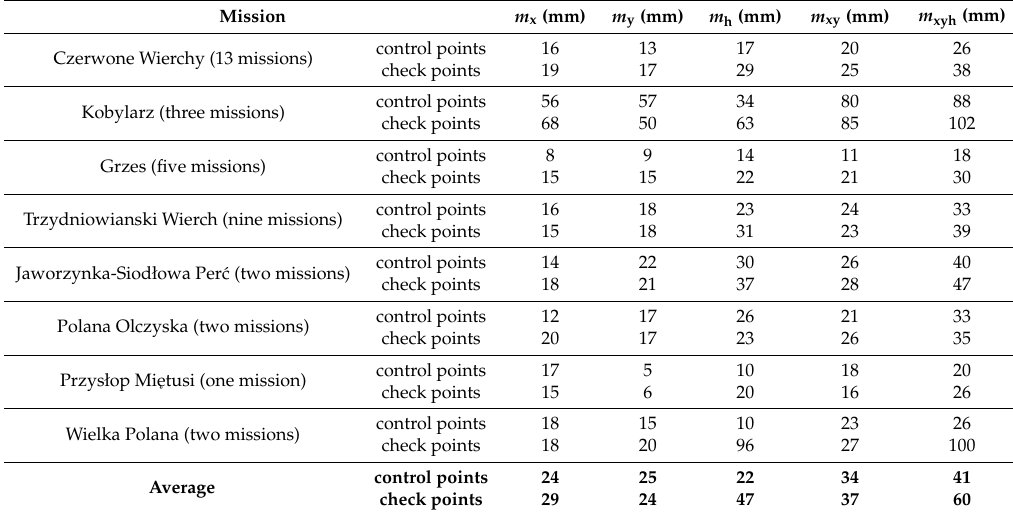
Table 2. The initial root mean square errors of control points and check points.